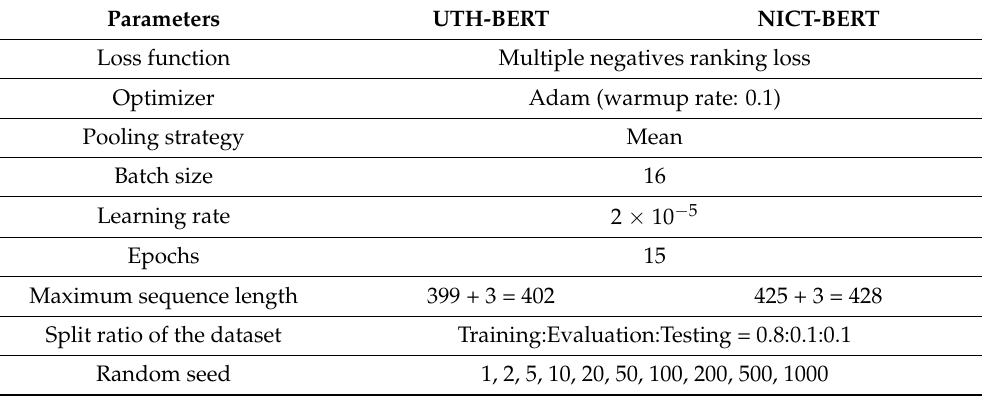
Table 2. Specific hyperparameters for SBERT training.